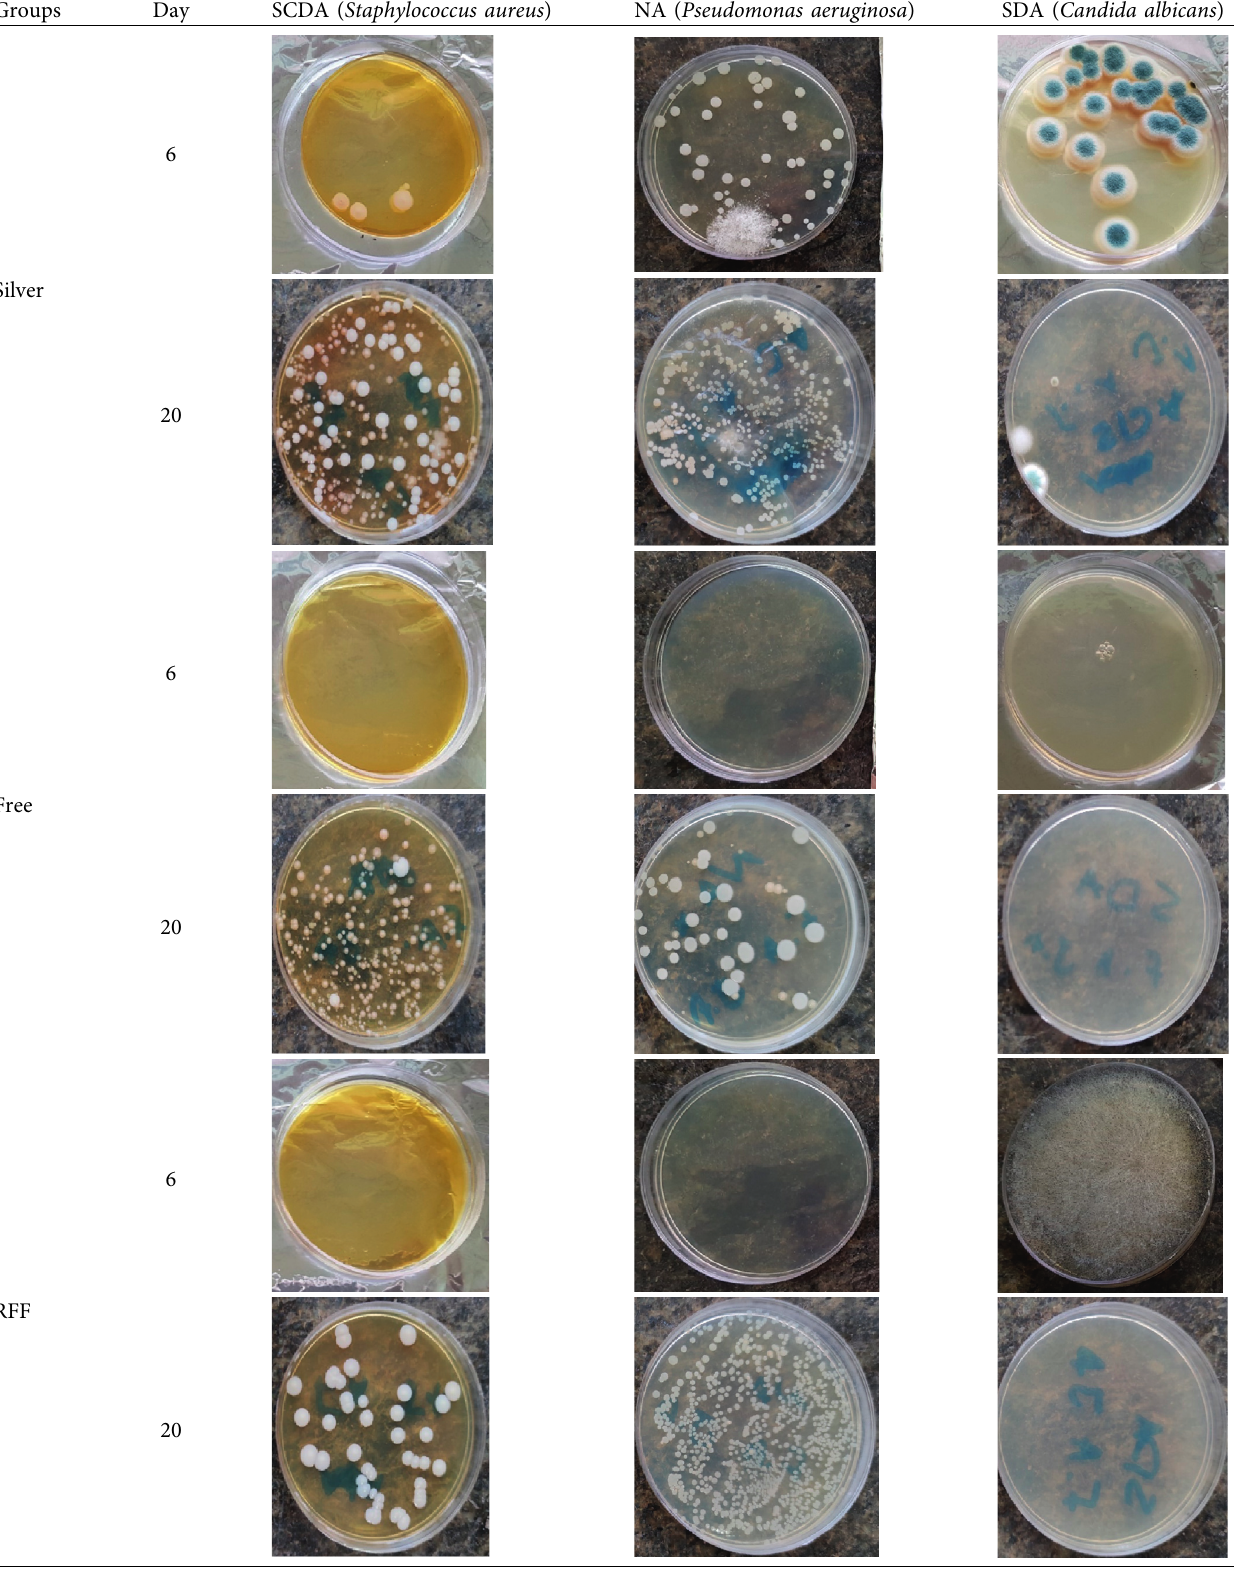
Table 3: Groups wound microbial analysis on days 6 and